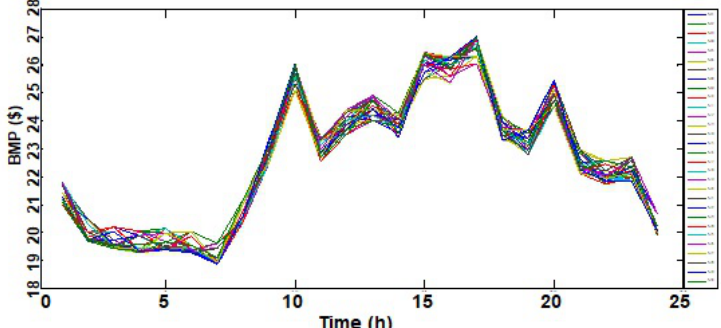
Figure 6. The BMP with 30 alternative scenarios.